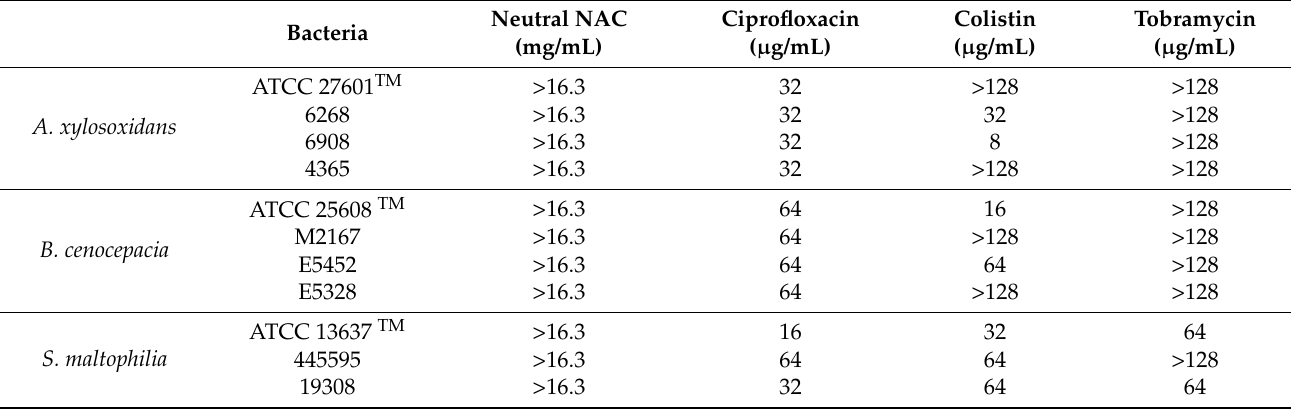
Table 2. Minimum Inhibitory concentrations (MIC) of bacterial strains used in study. Testing performed using broth microdilution method in planktonic